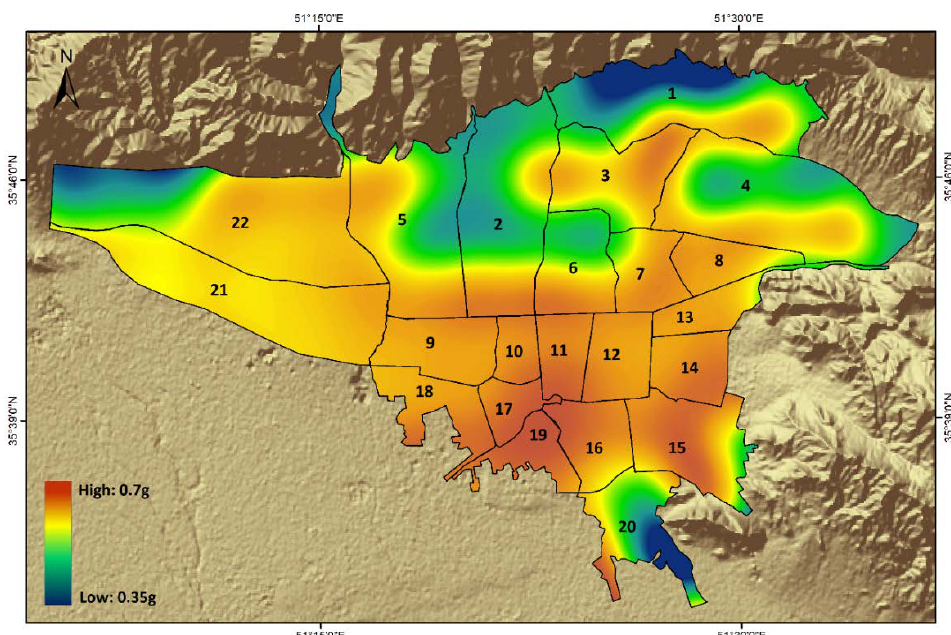
Figure 5. PGA on surface for 475-year return period.